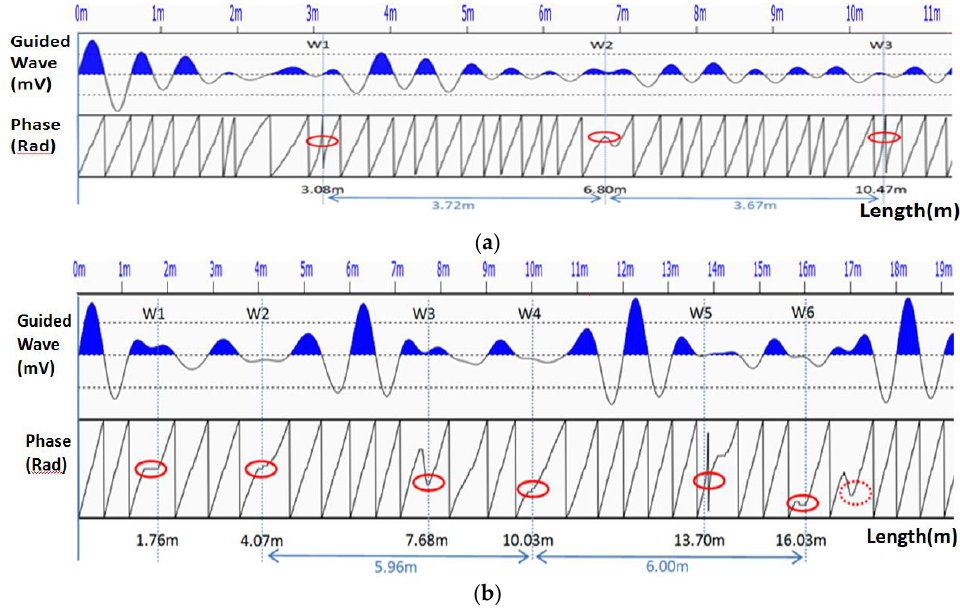
Figure 11. The received waveform and its instant phase. ( a ) Specimen No. 1; ( b ) Specimen No.2.